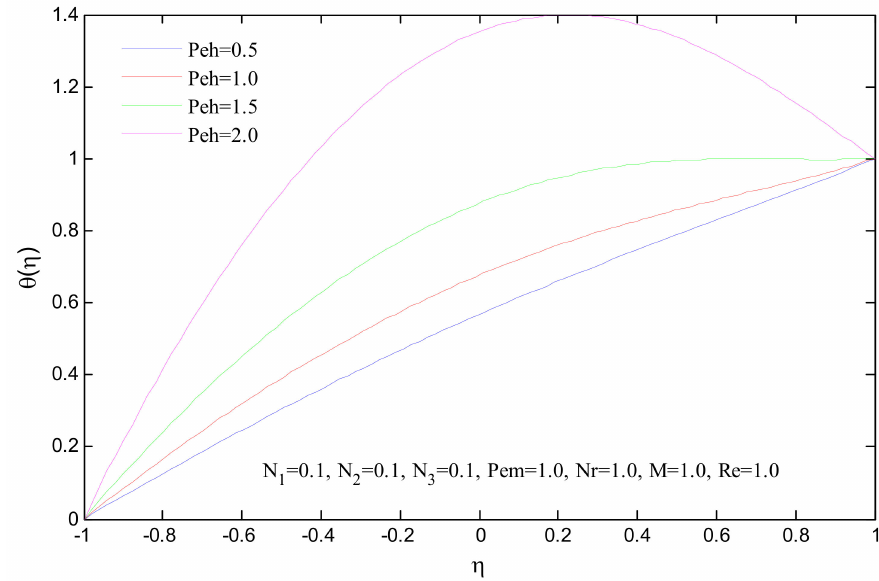
Figure 12. Effect of P eh on temperature profile.